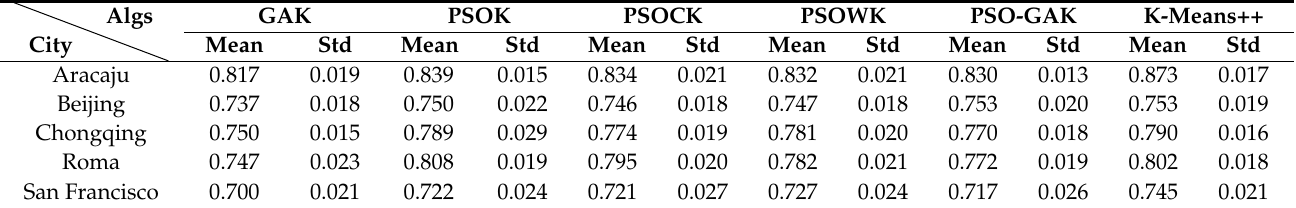
Table 10. CSI index for novel FPSO-GAK vs. other